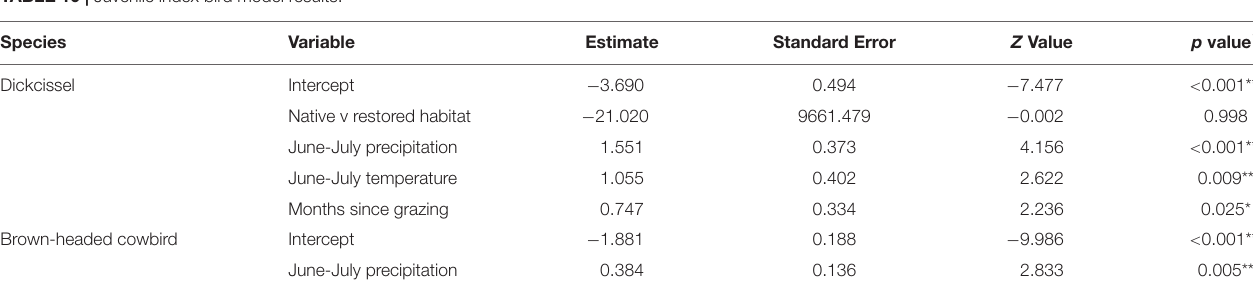
TABLE 10 | Juvenile index bird model results.